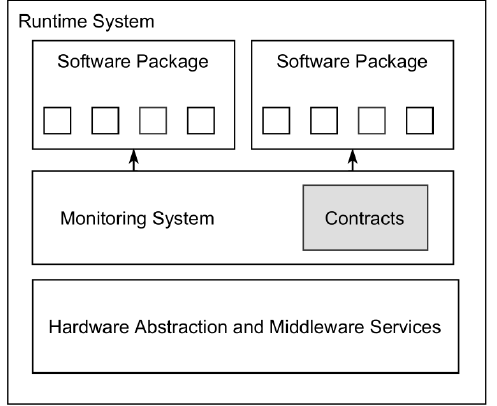
Figure 10. Monitoring of Updated Module During